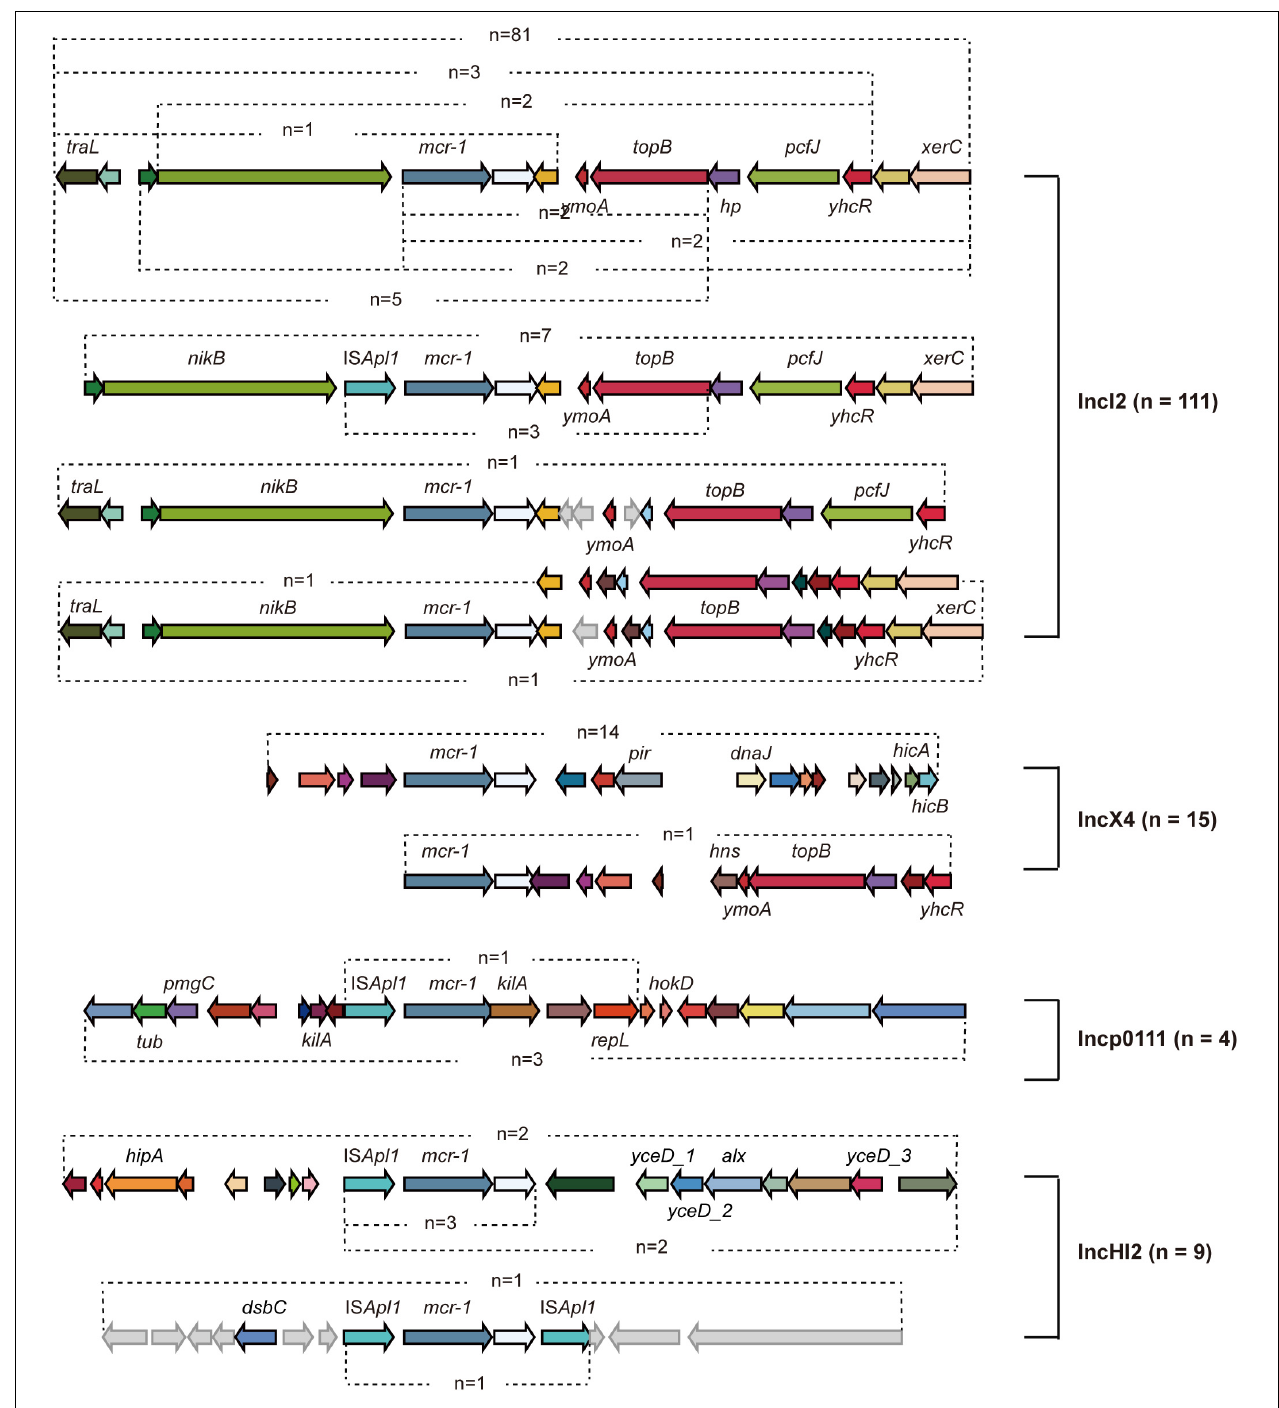
FIGURE 2 | Genetic analysis of mcr-1 - carrying plasmids. Different arrows represent particular genes having a name written underneath of each arrow. The arrows without names represent hypothetical